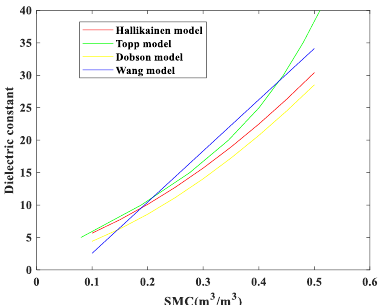
Figure 17 . The four soil models on Chinese loam soil （ C=0.45 ， S=0.15 ） .